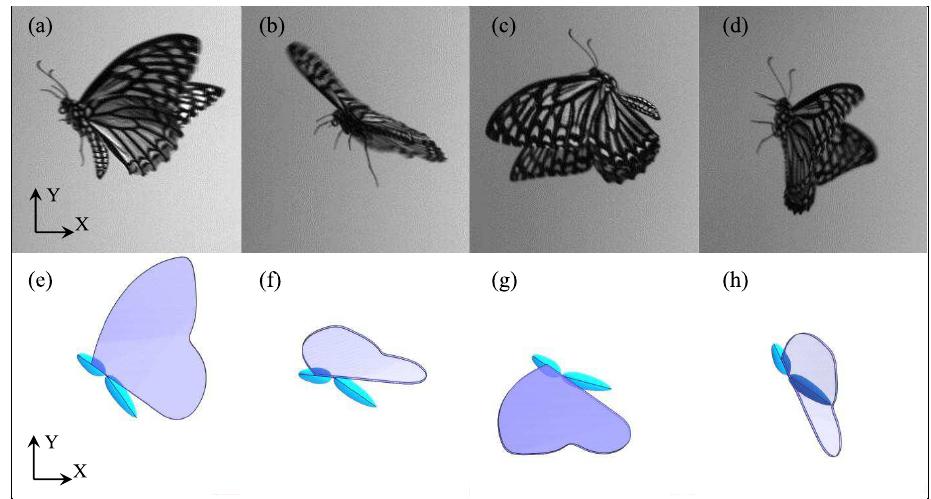
Figure 3. The real motion (top) and prescribed motion (bottom) of the butterfly during a stroke: ( a , e ) start of downstroke; ( b , f ) mid-downstroke; ( c , g ) start of upstroke; and ( d , h )